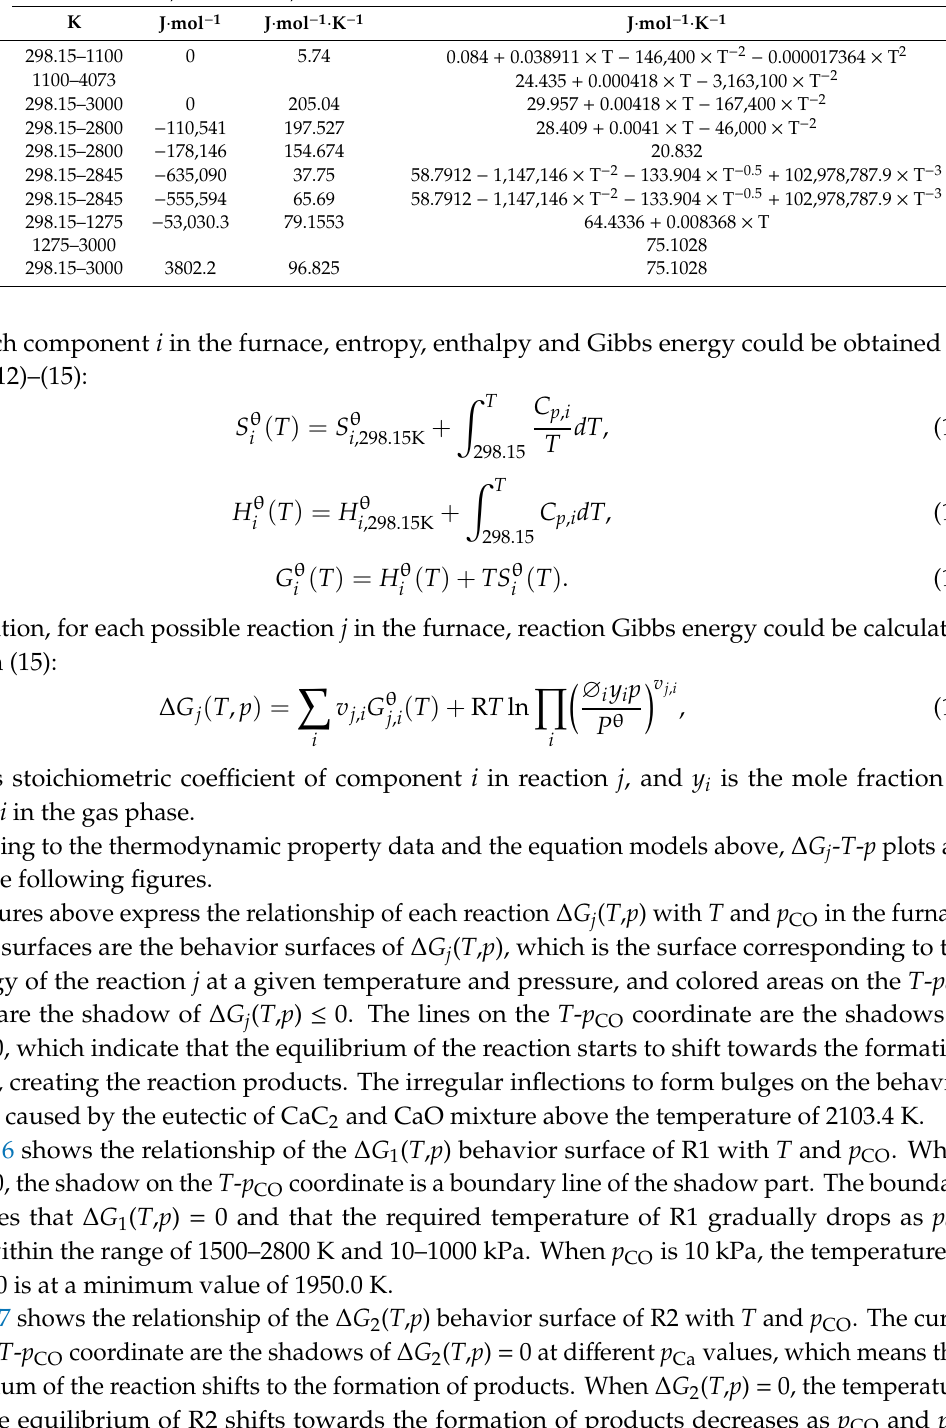
Table 1. Thermodynamic data H θ